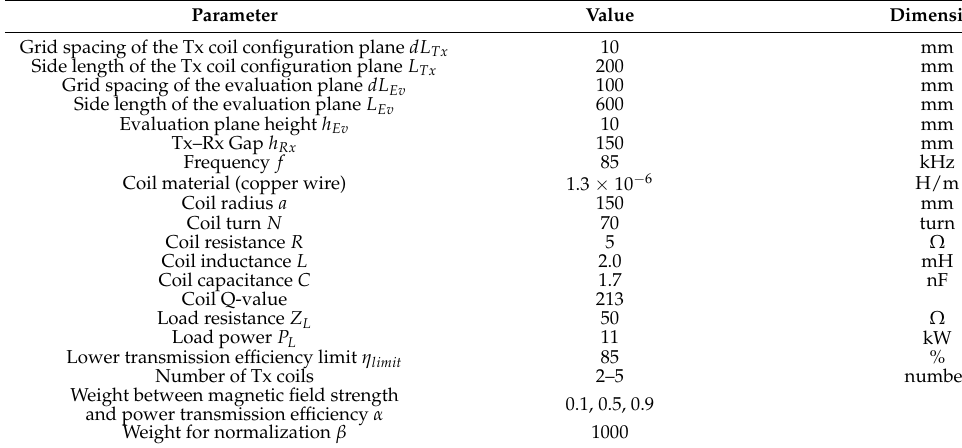
Table 2. Simulation parameters.